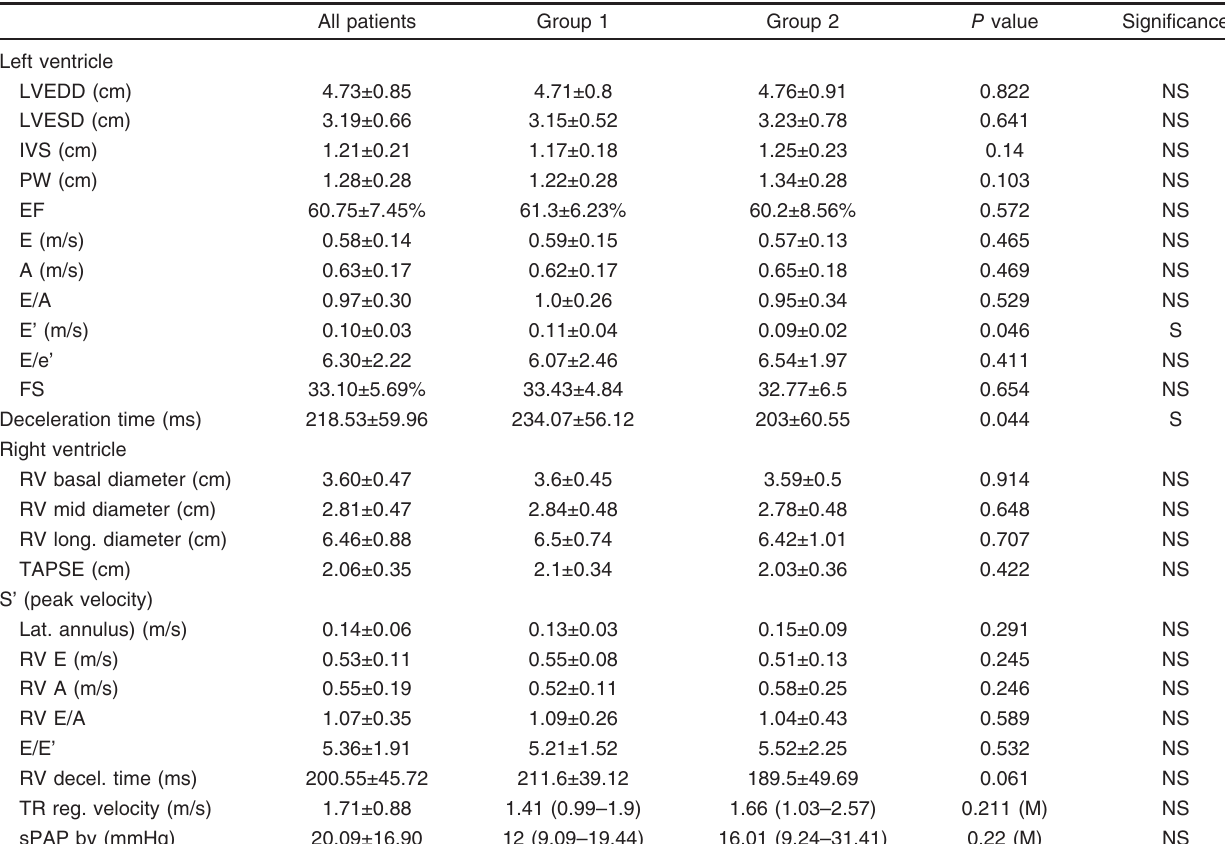
Mean echocardiographic parameters in the whole study group and compares between both study groups. EF, ejection fraction; FS, fractional shortening; IVS, interventricular septum (IVS) thickness; Lt vent A, transmitral A wave velocity; Lt vent e ’ , lateral mitral annulus e ’ wave velocity by tissue Doppler; Lt vent. E, transmitral E wave velocity; LVEDD, left ventricle end diastolic dimension; LVESD, left ventricle end systolic dimension; PW, posterior wall thickness; RV A, transtricusped A wave velocity; RV E, transtricusped E wave velocity; S ’ , right ventricle free wall velocity at tricuspid lateral annulus by tissue Doppler imaging; sPAP, estimated pulmonary artery pressure; TAPSE, tricuspid annular plane systolic